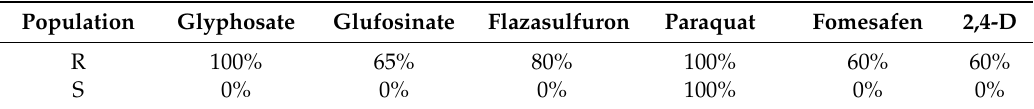
Table 2. Plant survival at field doses expressed as a percentage with respect to control (untreated) plants for di ff erent herbicides in two populations of Parthenium hysterophorus (resistant (R) and susceptible (S)) collected from banana plantations of the Dominican